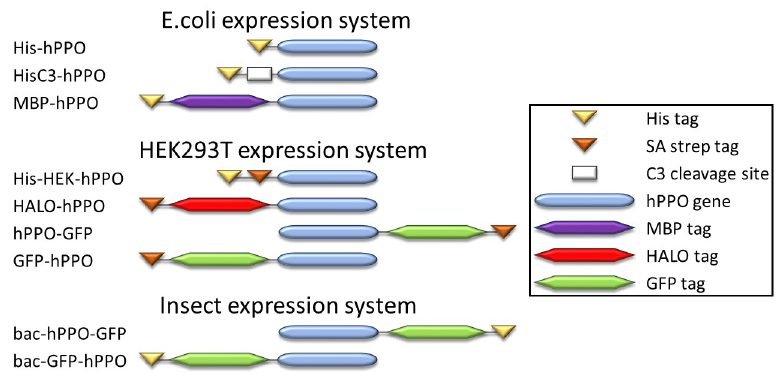
Fig 1. Schematic representation of hPPO constructs used in this study. C3 – C3-protease recognition site; Strep– Strep-tag; His–His tag.